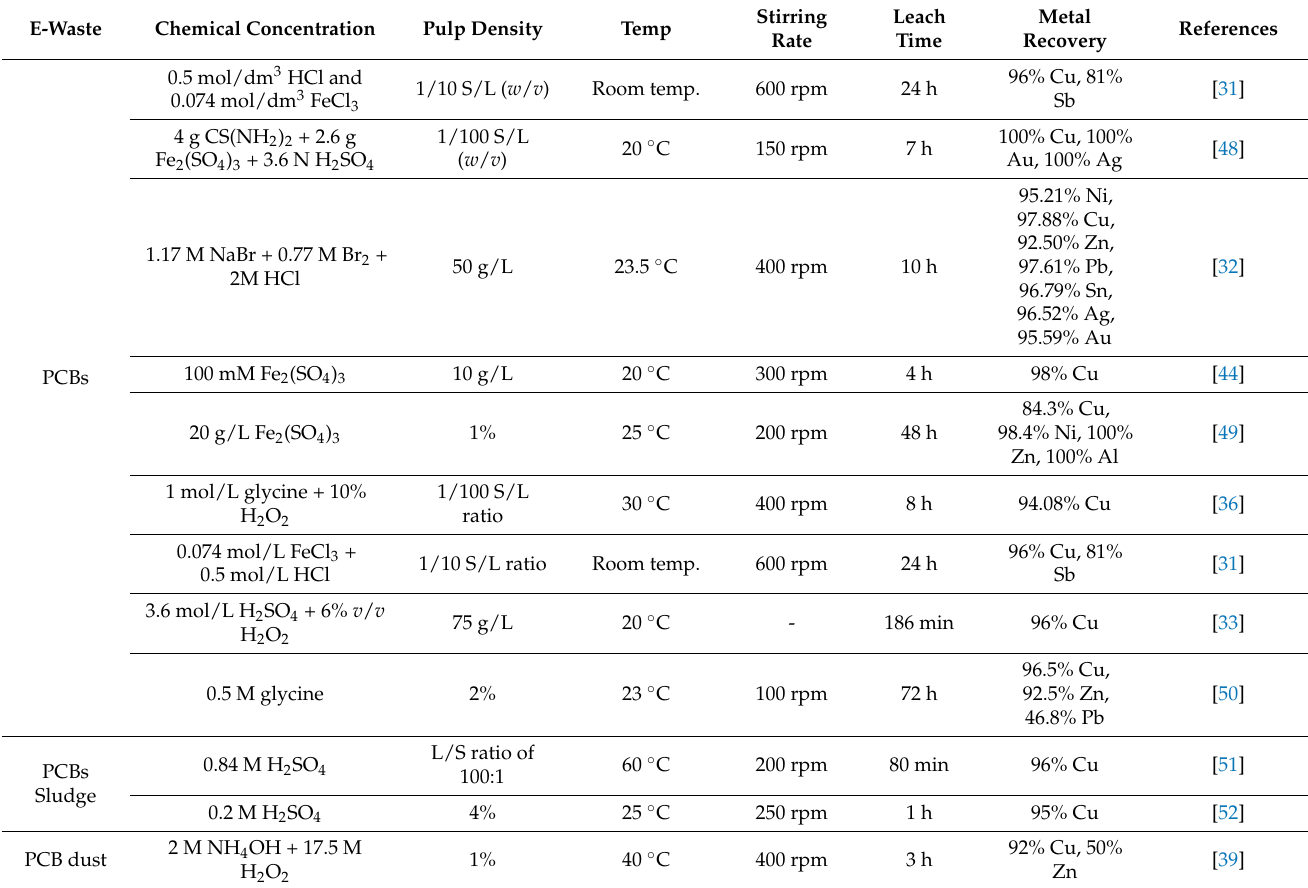
Table 1. List of some chemical leaching studies for metal recovery from selected e-waste streams along with their operation conditions (note: Au, Ag, Li, In, etc., have been presented, wherever applicable, to reflect the overall study along with base metal